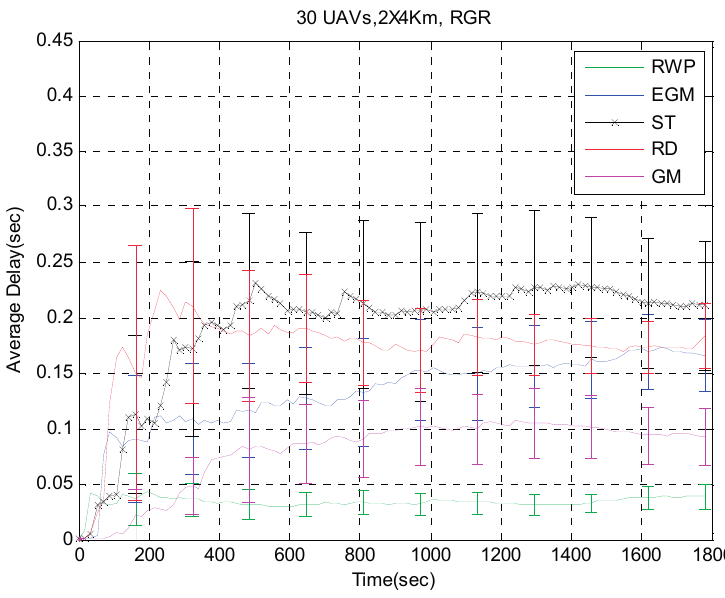
Figure 14. End-to-end delay of RGR under various mobility models.